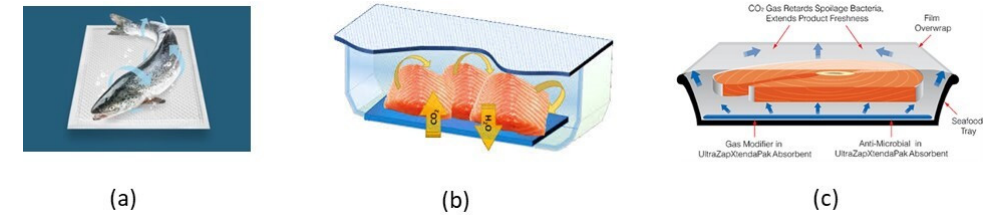
Figure 3. ( a ) CO 2 emitter pad, ( b ) CO 2 emitter and moisture absorber pad, ( c ) CO 2 emitter and